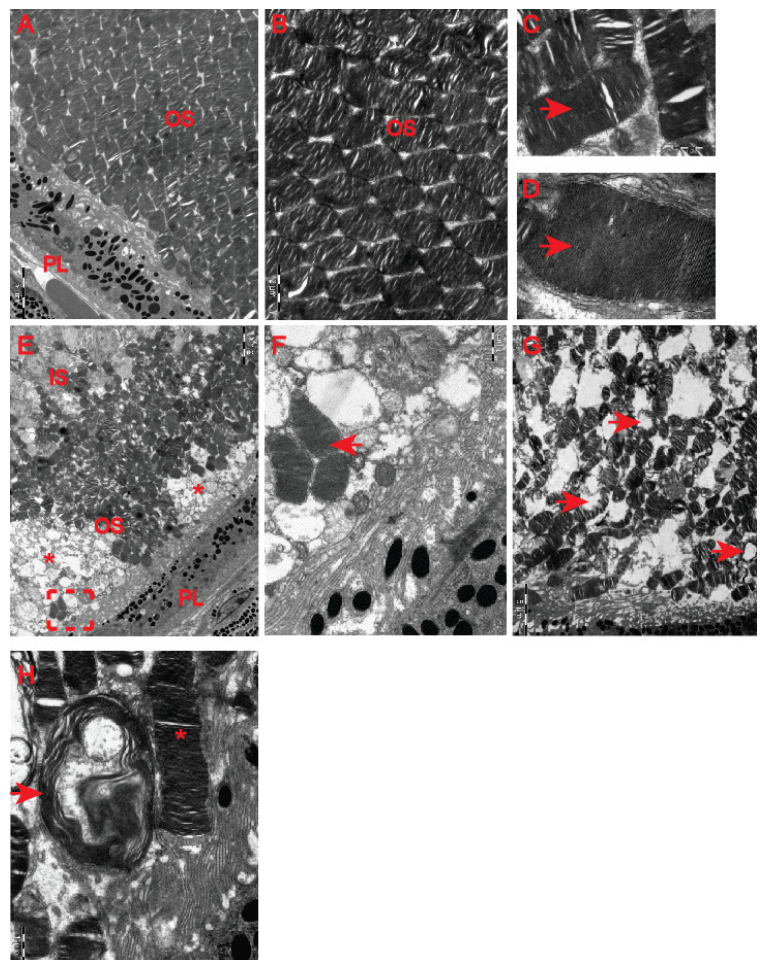
Figure 7. HD-related structural abnormalities in the retina. Representative electron micrographs of the retina in control age-matched mice ( A – D ) and in the symptomatic HD mice ( E – G ). ( A , B ) A typical structure of the light-sensitive outer segment (OS) containing the rod and cone photoreceptor cells, PL—pigment epithelium. ( C , D ) A higher magnification of electron microscopy pictograms representing regularly distributed columns containing parallel membrane disks (arrowheads)